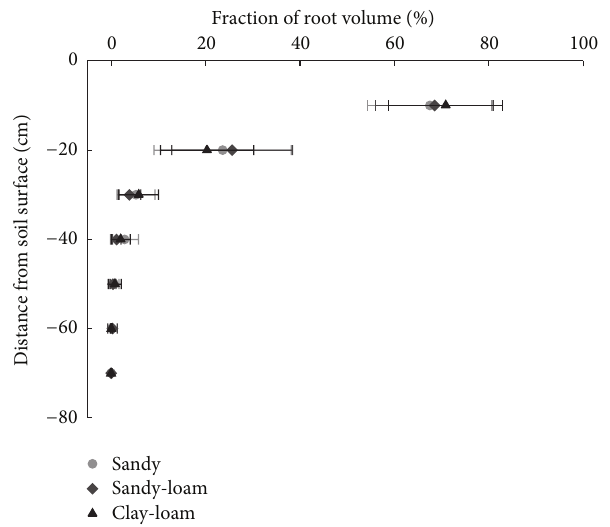
Figure 6: Root volume distribution by depth in sandy, sandy-loam and clay-loam